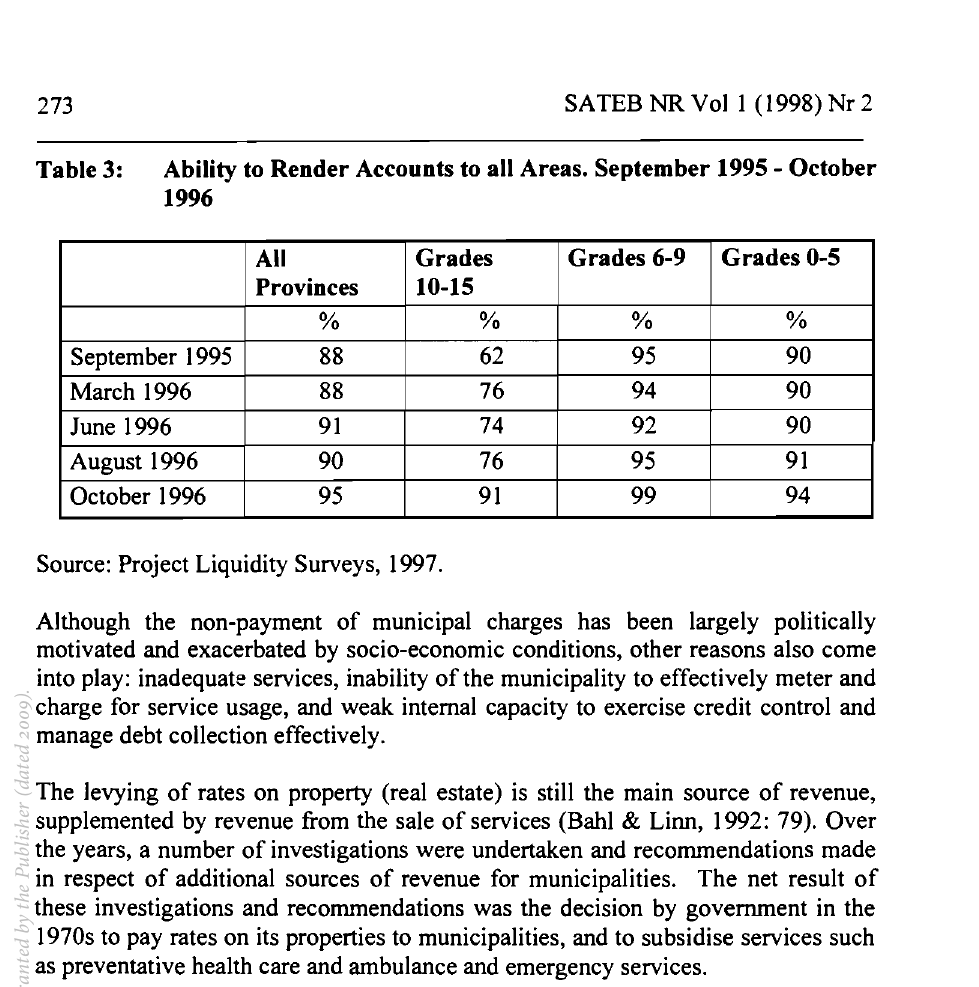
Ability to Render Accounts to all Areas. September 1995 - October 1996 All Grades Grades 6-9 Grades 0-5 Provinces 10-15 % % % % September